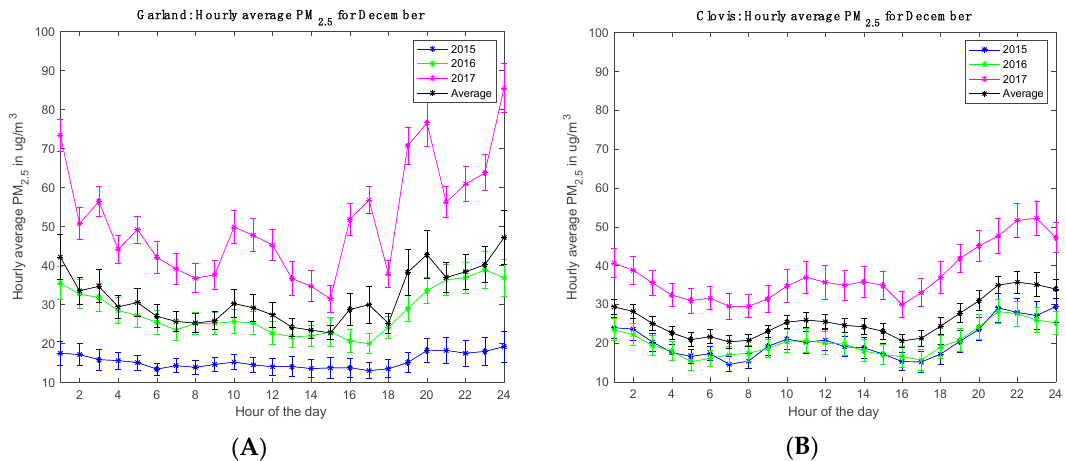
Figure 3. Hourly average PM 2.5 variation for Garland ( A ) and Clovis ( B ) during December.